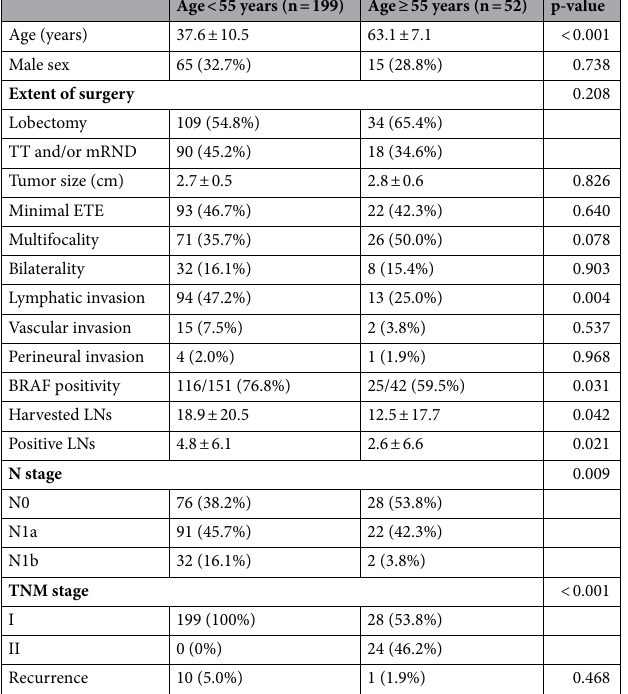
Table 4. Baseline clinicopathological characteristics according to age. Data were expressed as number (%) or mean ± standard deviation. A statistically significant difference was defined as p < 0.05. TT total thyroidectomy, mRND modified radical neck dissection, ETE extrathyroidal extension, LN lymph node, T tumor, N node, M